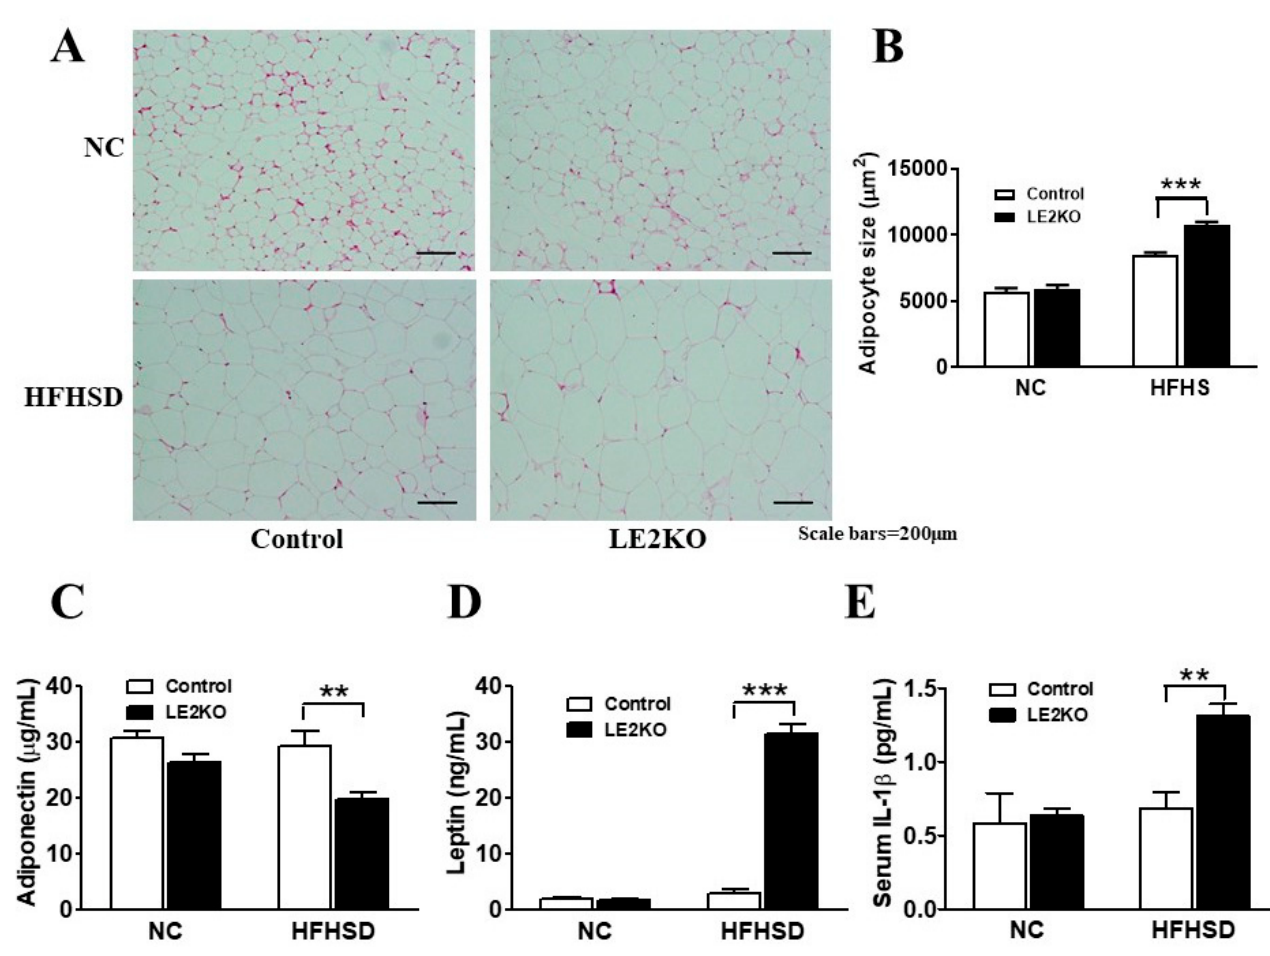
Figure 4. HFHSD-LE2KO display enlargement of adipocytes and changes in serum adipocytokines. ( A ) Typical microscopic images of adipocytes and ( B ) quantification of size of adipocyte ( n = 8 for each group). ( C – E ) Serum adiponectin levels were lower and serum leptin and IL-1 β levels were markedly higher in HFHSD-LE2KO than HFHSD-Control. ( n = 8 for each group). Error bars represent SEM; p values were determined by ANOVA (** p < 0.01, *** p < 0.001 vs. HFHSD-Control).